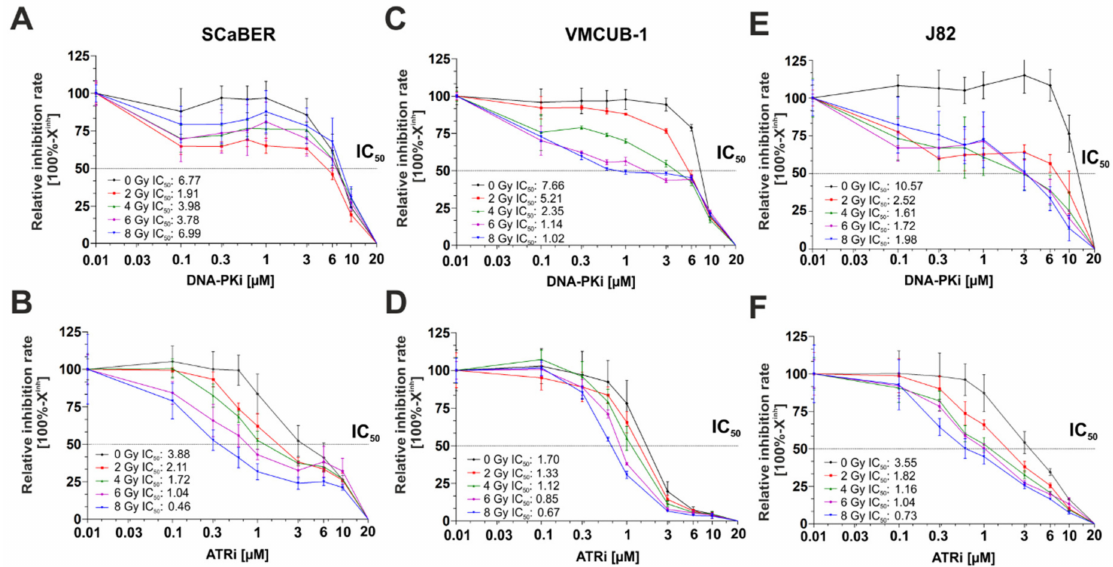
Figure 1. IC 50 values of ATR and DNA-PK inhibitors in relation to radiation dose and cellular background. Short-term single drug response analyses applying DNA-PK and ATR inhibitors upon different radiation doses (0 Gy, 2 Gy, 4 Gy, 6 Gy, 8 Gy) on squamous SCaBER ( A , B ), urothelial VMCUB- 1 ( C , D ) and J82 ( E , F ) bladder cancer cell lines. Semi-logarithmic plots show drug response curves (relative inhibition rate = 100% − X inh ) of urothelial bladder cancer cell lines. Drug response was determined using XTT following 72 h incubation with indicated drug concentrations and radiation doses. Dotted line and stated relative IC 50 = drug concentration causing 50% inhibition. Drug response curves represent means from at least n = 3 independent